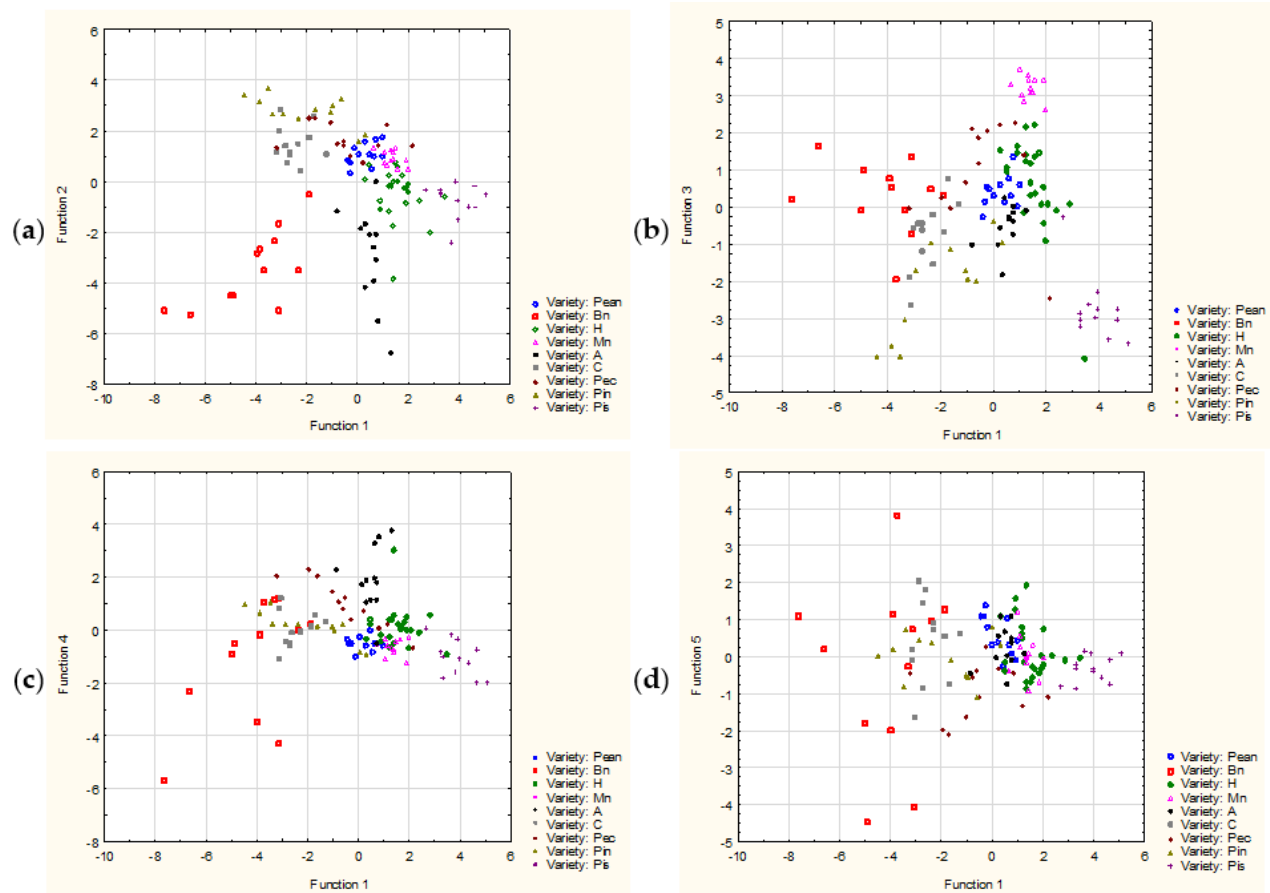
Figure 3. Discriminant analysis scatter plots for factors 1 and 2 ( a ), 1 and 3 ( b ), 1 and 4 ( c ), and 1